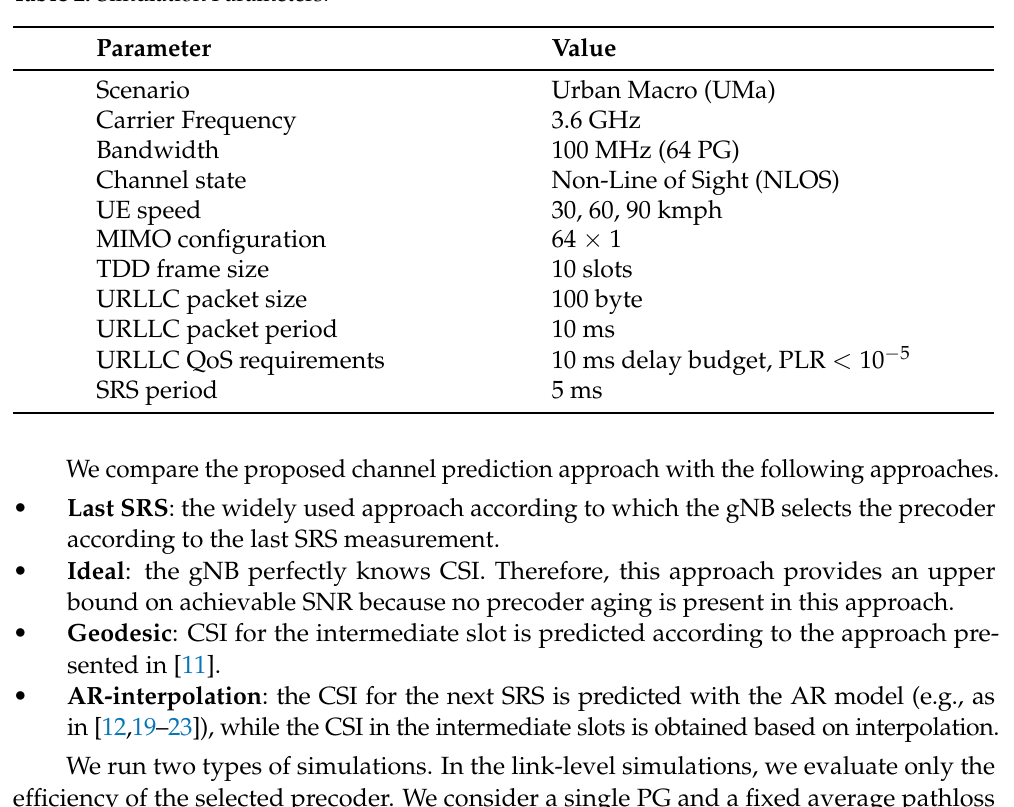
Table 2. Simulation